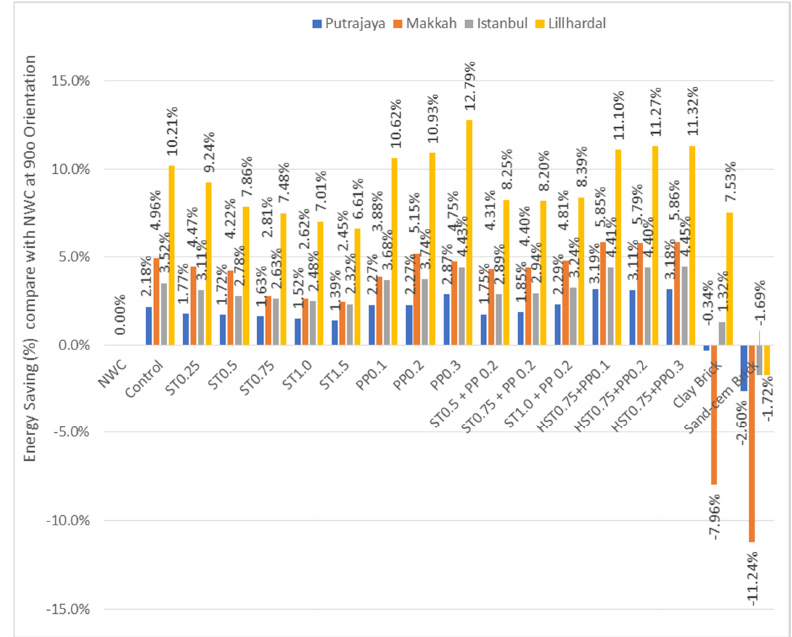
Figure 10. Percentage of energy saving using fibre-reinforced LECA-LWAC as compared with NWC. In Makkah, for the building with front elevation facing east (90° orientation), HST0.75 + PP0.3 (5.86%) had the best overall energy followed closely by HST0.75 + PP0.1 (5.85%). In the ST category, ST0.25 had the highest energy saving at 4.47%. In the ST + PP0.2 hybrid category, ST1.0 + PP0.2 had the highest energy saving at 4.81%. The order of energy-saving materials based on the category from high to low in Makkah was HST0.75 + PP0.1 > PP0.3 > ST1.0 + PP0.2 > ST0.25. In Istanbul, HST0.75 + PP0.3 (4.45%) followed closely by PP0.3 (4.43%) had the best overall energy savings compared with NWC and all other fibre configurations. In the ST category, ST0.25 had the highest energy saving of 3.11% compared with NWC. In the ST + PP0.2 hybrid category, ST1.0 + PP0.2 had the highest energy saving of 3.24% in contrast to NWC. The order of energy-saving material based on the category from high to low in Istanbul was HST0.75 + PP0.1 hybrid > mono PP0.3 > ST1.0 + PP0.2 hybrid > mono ST0.25 > NWC > Brick. In Lillhardal, PP0.3 provided the best overall energy saving of 12.79% followed closely by HST0.75 + PP0.3 with 11.32% as compared with NWC and all other fibres. In the ST category, ST0.25 had the highest energy saving of 9.24% as compared with NWC. In the ST + PP0.2 hybrid category, ST1.0 + PP0.2 displayed the highest energy savings of 8.39% with respect to NWC. The order of energy-saving material based on the category from high to low was mono PP > HST0.75 + PP hybrid > ST + PP0.2 hybrid > mono ST > NWC > Brick. In the cold sub-arctic climate of Lillhardal, the mono PP0.3 fibre performed better in terms of energy savings, whereas, in the hot-humid climate of Putrajaya and warm Mediterranean climate of Istanbul, the HST0.75 + PP was the best in terms of energy savings. The effect on energy savings of